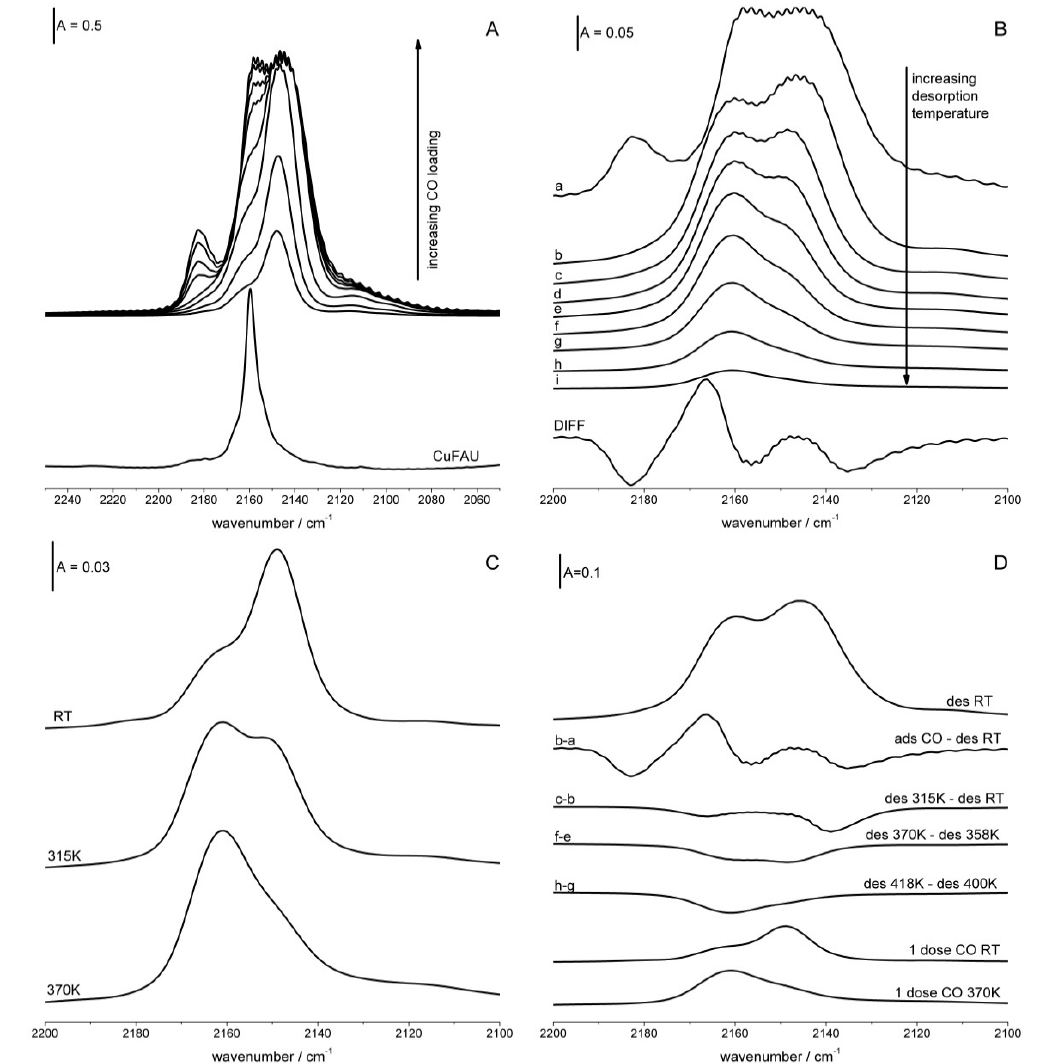
Figure 2. ( A ) The spectra recorded upon the sorption of increasing amounts of CO at room temperature in zeolite CuY. Bottom spectrum is the spectrum of CO sorbed in zeolite CuFAU (Si/Al = 31). ( B ) The spectrum recorded upon the sorption of CO at room temperature (top spectrum), spectra recorded upon the desorption of CO at vacuum in the temperature range 300–520 K, as well as difference between the spectra recorded upon desorption at 300 K and adsorption of CO. ( C ) The spectrum recorded upon the sorption of a small dose of CO at room temperature and heating to 315 and 370 K. ( D ) The spectrum of CO sorbed in zeolite CuY at room temperature, difference spectra recorded upon the desorption at various temperatures, and the spectrum of a small dose of CO sorbed at room temperature and upon heating to 315 and 370 K.